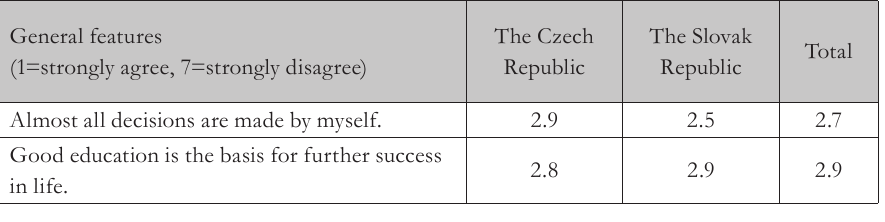
Tab. 2 – General Features of Behavior in the Czech Republic and Slovakia (Mean